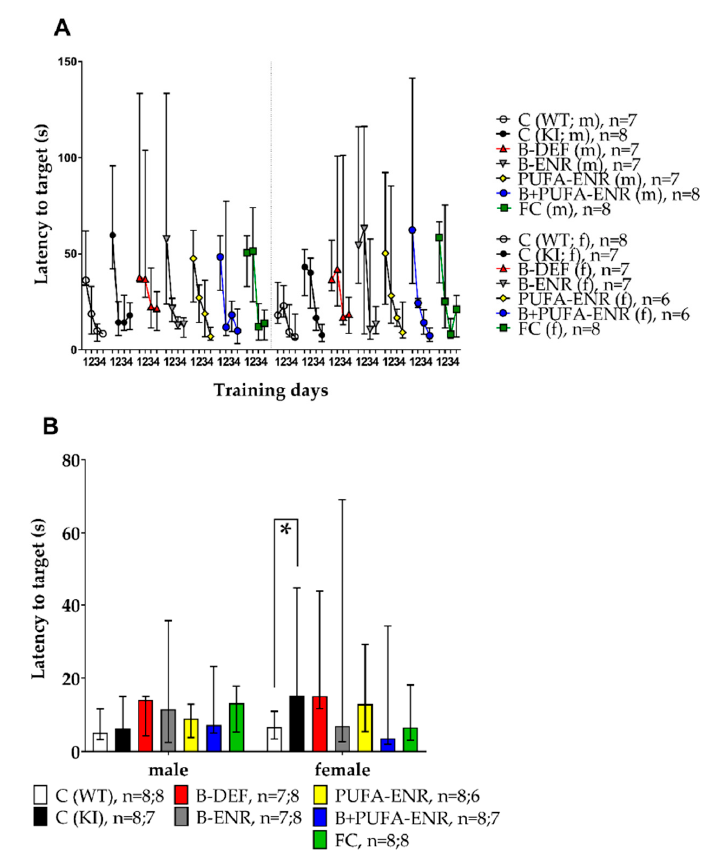
Figure 6. Barnes maze test in 17–18 weeks old C57BL / 6J and App NL-G-F mice; 12–13 weeks on experimental diet; data presented as median ± IQR; outliers beyond threefold IQR removed; p < 0.05 (Mann-Whitney-U-test) considered statistically significant (*). ( A ) Latency to target hole; training days 1–4; 180 s per trial; acquisition phase; test on statistical significance carried out for day 4. ( B ) Latency to target hole; day 5; 90 s per trial; probe trial.